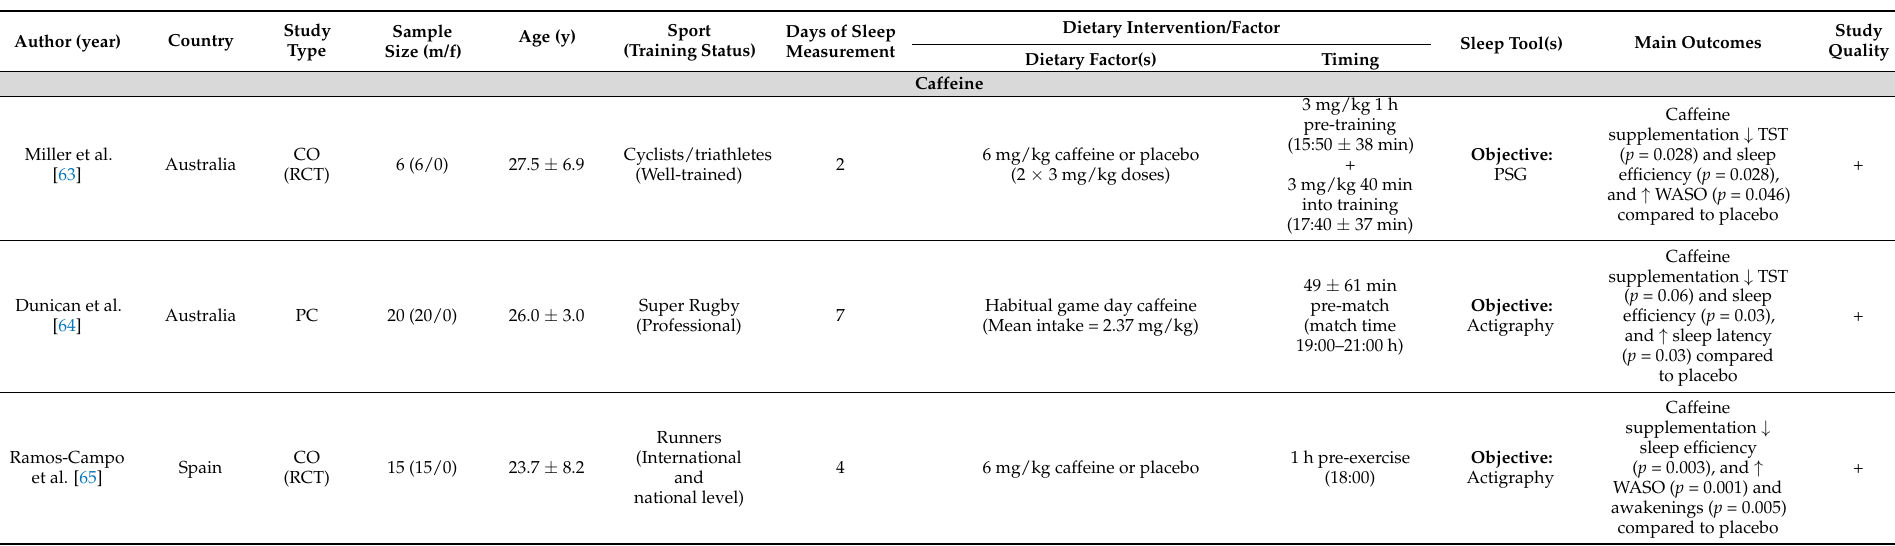
Table 3. Studies investigating the influence of dietary supplements on the sleep of athletically trained